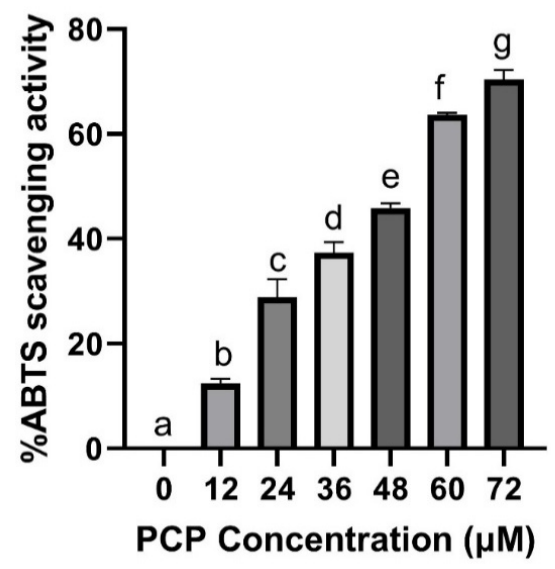
Figure 4. Antioxidant activity of purified PCP on ABTS radical scavenging activity. Results represent the mean ± SD of three replicates. Different superscript letters on column bars denotes significant difference at p < 0.05.